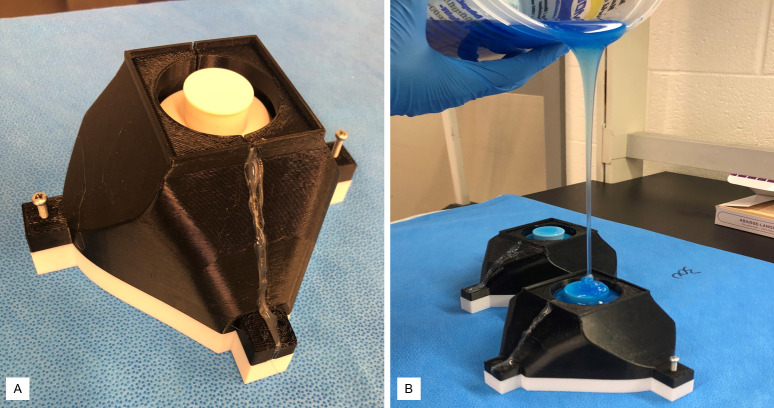
a) Assembled 4-part mold b) Silicone pouring into molds. (a) The 4-part printed mold is shown assembled using two screws. The two-halves of the cover were glued for sealing. (b). Silicone was poured from a high distance to eliminate bubble formation in the mold.